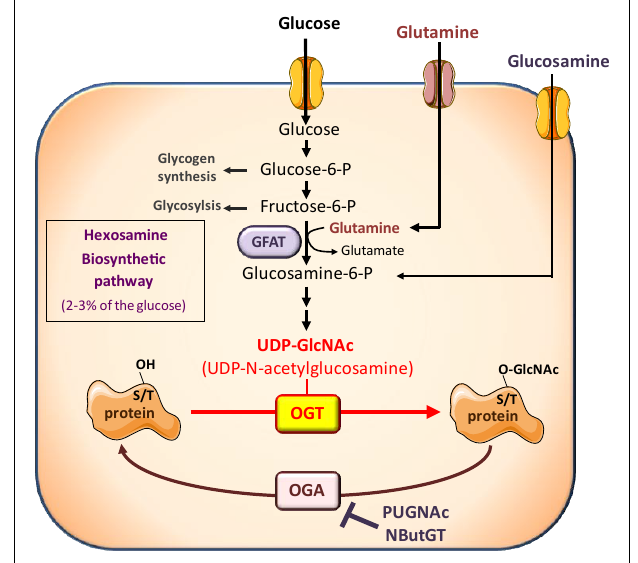
FIGURE 1 |The hexosamine biosynthetic pathway and protein O -GlcNAcylation .The hexosamine biosynthetic pathway (HBP) controls O -GlcNAc glycosylation ( O -GlcNAcylation) of nuclear and cytosolic proteins. This dynamic and reversible post-translational modification controls activity, localization, or stability of substrate proteins, according to the rate of glucose availability. A fraction (2–3%) of glucose entering the cell is directed to the HBP. In this pathway, fructose-6-phosphate is converted to glucosamine-6-phosphate by the glutamine:fructose-6-phosphate amidotransferase (GFAT), the rate-limiting enzyme of the pathway. After a subset of reactions, UDP- N -acetylglucosamine (UDP-GlcNAc) is generated and used by the O -GlcNAc-transferase (OGT) as a substrate to add GlcNAc to serine or threonine residues of target proteins. O -GlcNAc moiety is removed from O -GlcNAc-modified proteins by the O -GlcNAcase (OGA). Experimentally, the level of O -GlcNAc-modified proteins in cells can be manipulated by exposing cells to high glucose concentrations or to glucosamine which enters the HBP downstream the rate-limiting GFAT-mediated reaction, as glucosamine-6-phosphate. In addition, OGA can be inhibited by pharmacological agents such as O -[2-acetamid- O -2- deoxy- D -glucopyranosylidene] amino- N -phenylcarbamate (PUGNAc) or 1,2-dideoxy-2 (cid:48) -propyl-alpha- D -glucopyranoso-[2,1-D]-Delta 2 (cid:48)